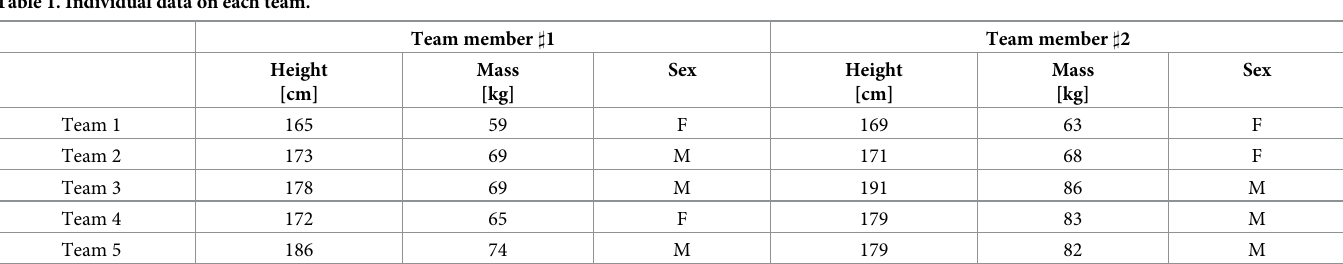
Table 1. Individual data on each team.